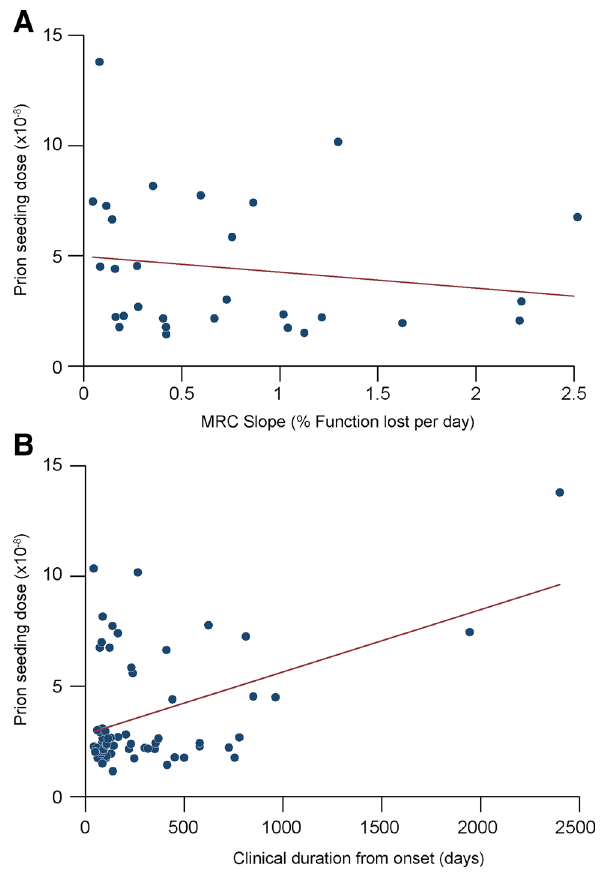
Figure 5. Correlation of CSF prion seeding doses with functional decline and duration of illness. Correlation of the MRC Scale slope (percentage decline in function per day) with prion seeding dose by RT-QuIC ( A ), and Correlation of the clinical duration from symptom onset with prion seeding dose by RT-QuIC ( B ). No correlation was seen with rate of functional decline ( A ) but a positive correlation was found ( r = 0.44, p = 0.0004) with total duration of illness. However the latter positive correlation is dependent on 2 extreme outliers with long durations of